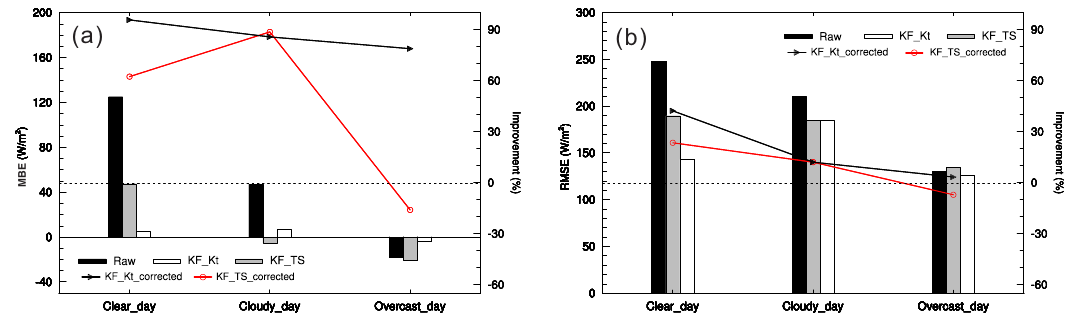
Figure 8. A comparison of the MBE ( a ) and RMSE ( b ) of KF_TS (solid gray bar) and KF_Kt (solid white bar) predictions with respect to the raw WRF predictions (solid black bar) for three sky conditions. The marked lines stand for the relative improvement of the KF_TS (red) and KF_Kt (black) against the raw forecasts of the WRF model at the Maizuru